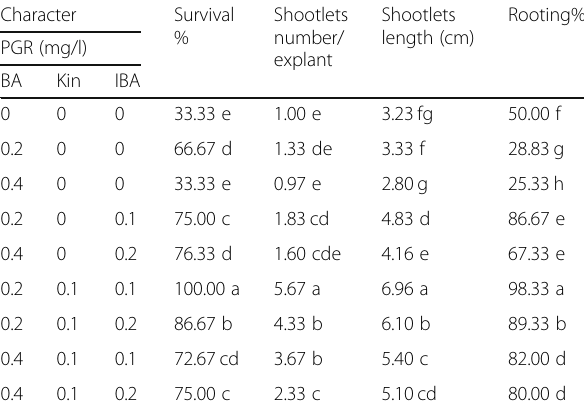
Table 1 In vitro propagation ability of Paulownia tomentosa effecting by plant growth regulators